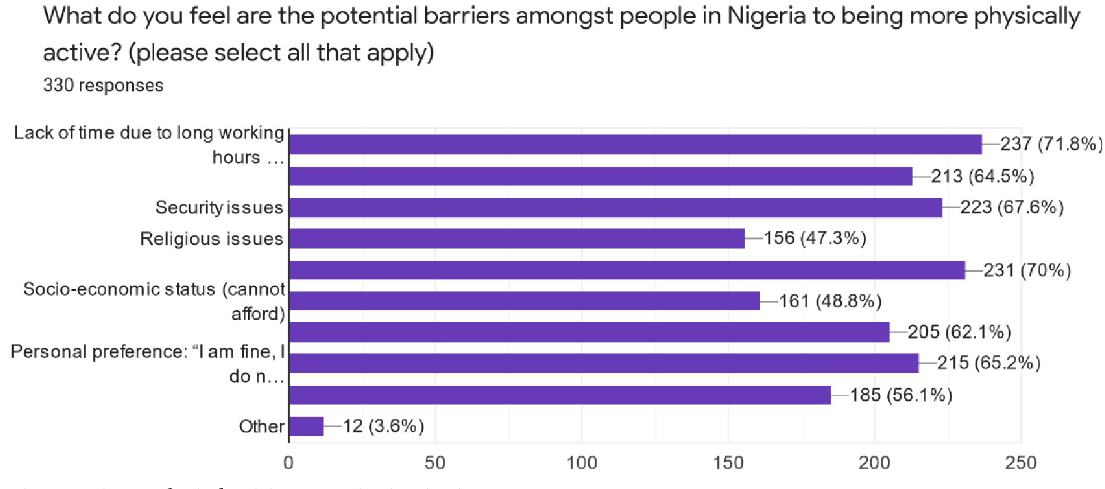
Fig 3. Barriers to physical activity promotion in Nigeria.